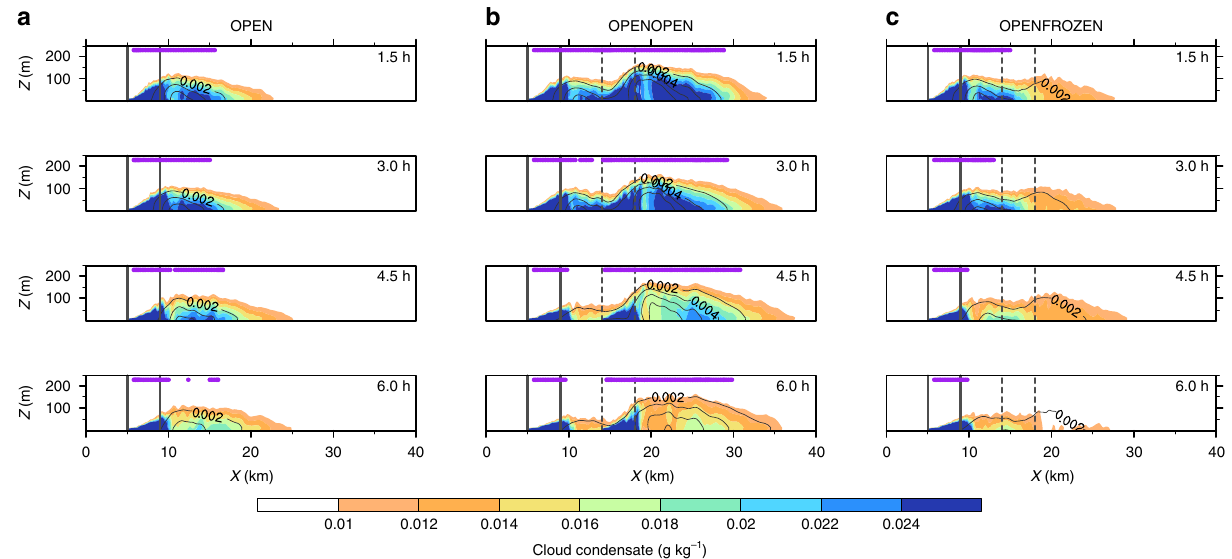
Fig. 3 Evolution of the simulated clouds response to leads. a The x – z pro fi les of the cloud condensate (cloud water plus cloud ice mixing ratio, shaded contour lines) and precipitating water (rain and snow, solid contour lines with intervals of 0.002 g kg − 1 ) from the OPEN case. b – c The same as a but for the OPENOPEN and OPENFROZEN cases, respectively. For each case, four simulation times (1.5, 3.0, 4.5, and 6.0 hrs) are displayed. The purple bars near the top of the selected domain indicate the place where the clouds are radiatively signi fi cant, with a total water path greater than 3.0 g m − 2 . All results are averaged along the y direction. The upstream open lead extends from x = 5 km to x = 9 km, as indicated by the two vertical solid lines in the domain, and the downstream open or frozen lead extends from x = 14 km to x = 19 km, as indicated by the two vertical dashed lines. Note that the scales are different on the x and y axis.